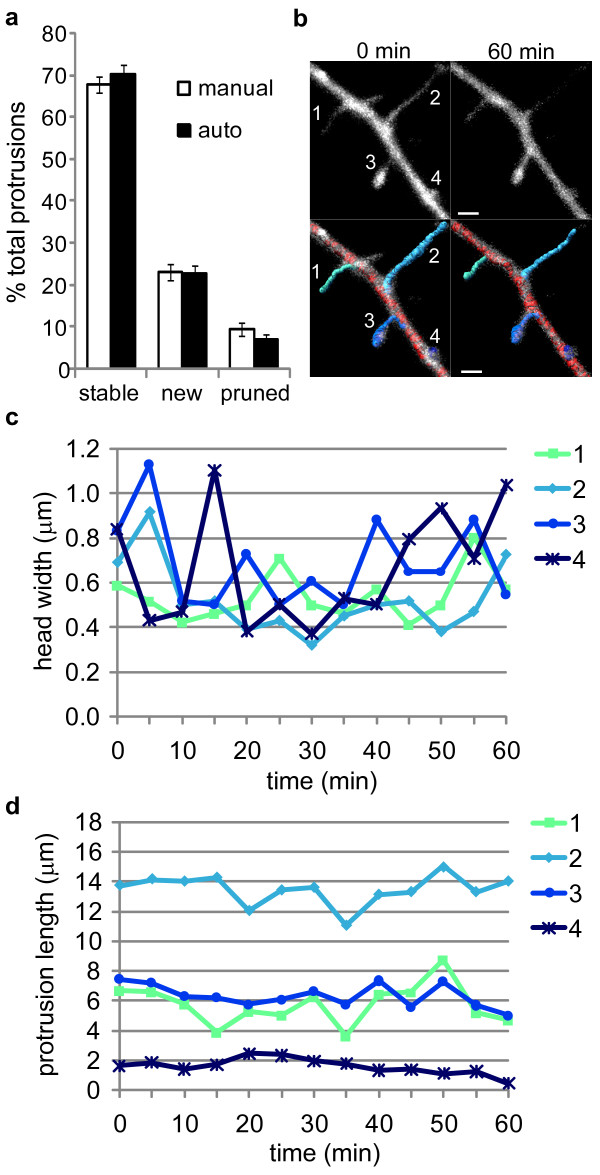
Automated tracking of dendritic protrusions in live neurons. 11 DIV hippocampal neurons were transfected with a vector expressing Lifeact-ruby, and 24 hrs later were imaged at 5 min intervals for 1 hr. (a) Individual protrusions were tracked across the time series manually and with our automated method. This histogram shows the percentages of stable, new, and pruned protrusions for both methods. (b) Images depict 12 DIV neurons expressing Lifeact-ruby (white; top) overlayed with automated 3D reconstructions (bottom). The dendrite shaft is red and each tracked protrusion is labeled 1 through 4 (shades of blue and green). Images from t = 0 and 60 min are shown, and the scale bar is 5 μm. (c) Head width and (d) protrusion length were plotted versus time for each protrusion; the labels 1 through 4 in the legend correspond to the labels 1 through 4 in panel (b).